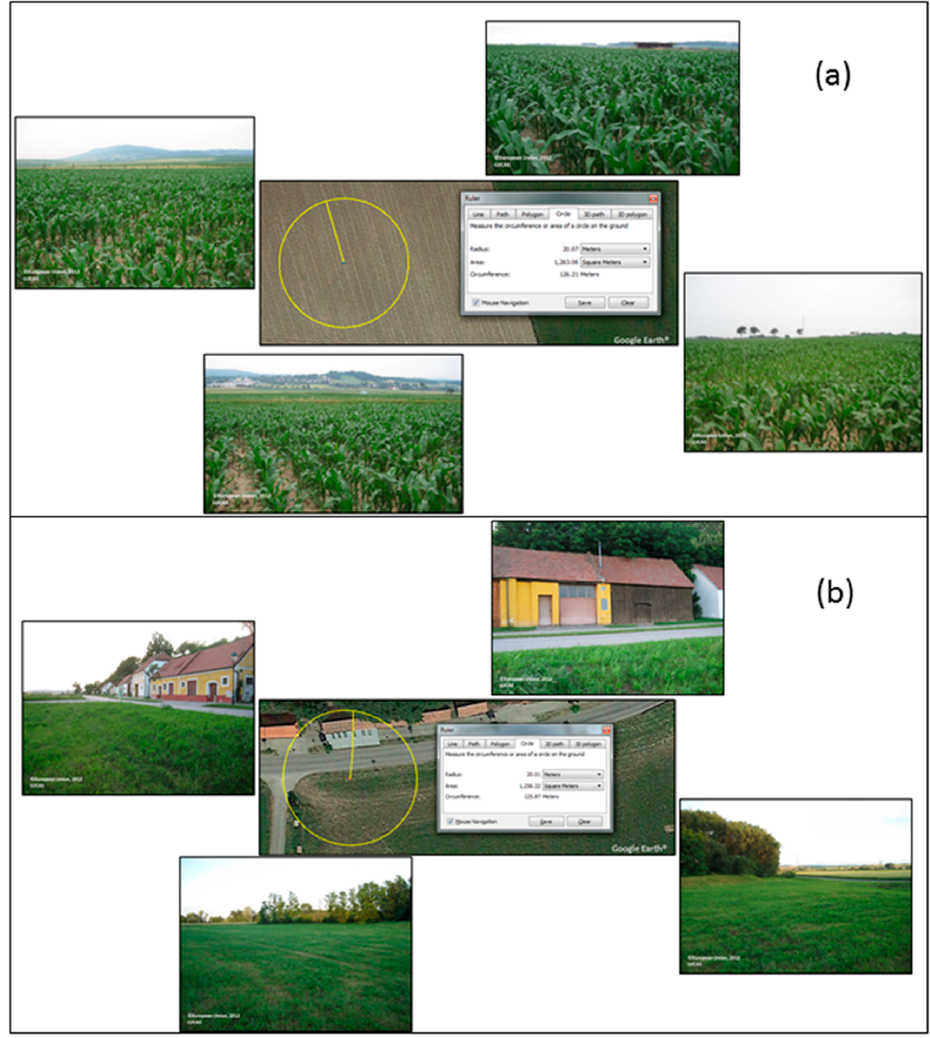
Figure 5. Examples of points with: ( a ) homogeneous; and ( b ) heterogeneous/mixed landscapes as determined by inspecting the LUCAS pictures and Google Earth ® satellite imagery. The circle radius is approximately 20 meters around the point.